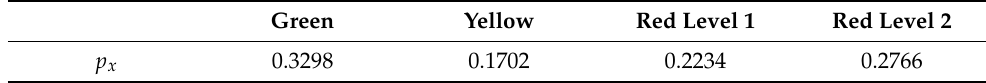
Table 11. Probability occurrence of all tariff flags—Hydrological adverse conditions.